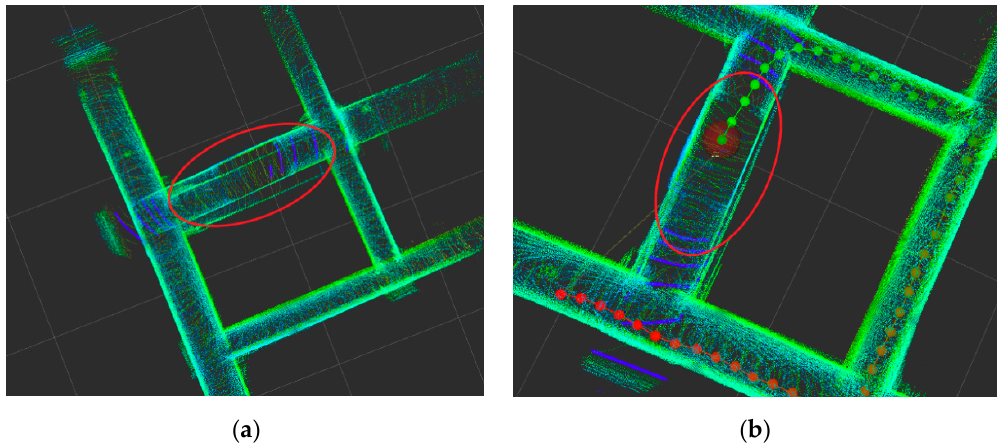
Figure 13. Comparison of point cloud registration based on ( a ) Normal Distributions Transform (NDT) and ( b ) GICP.